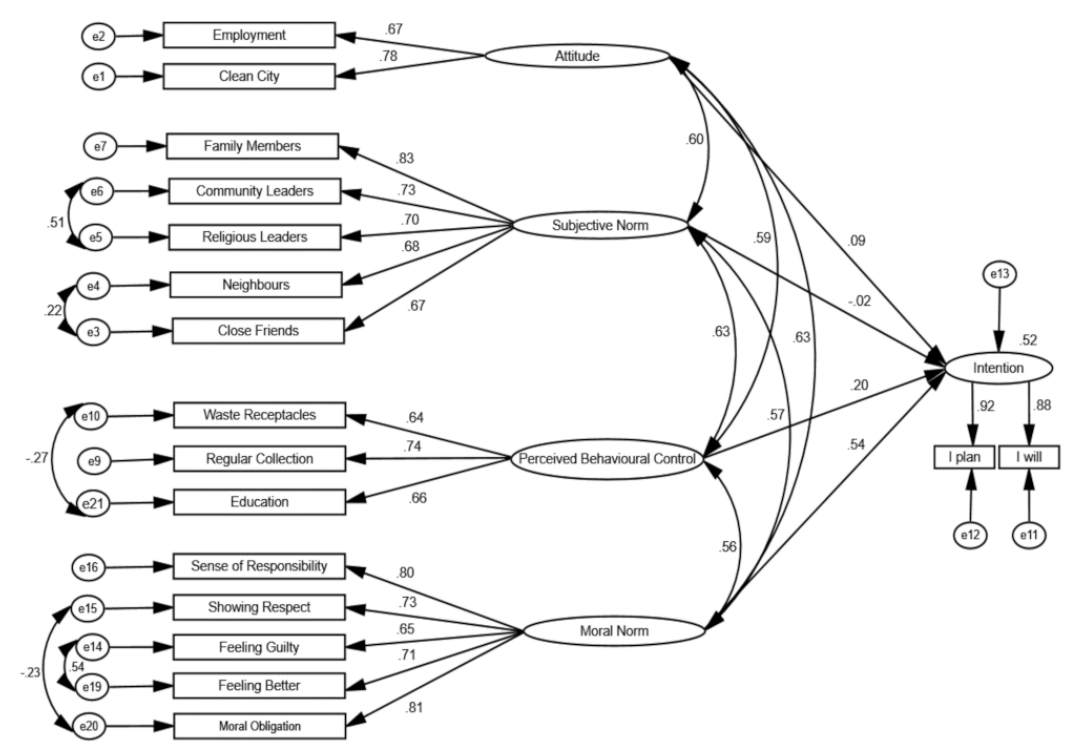
Figure 5. The modified structural equation